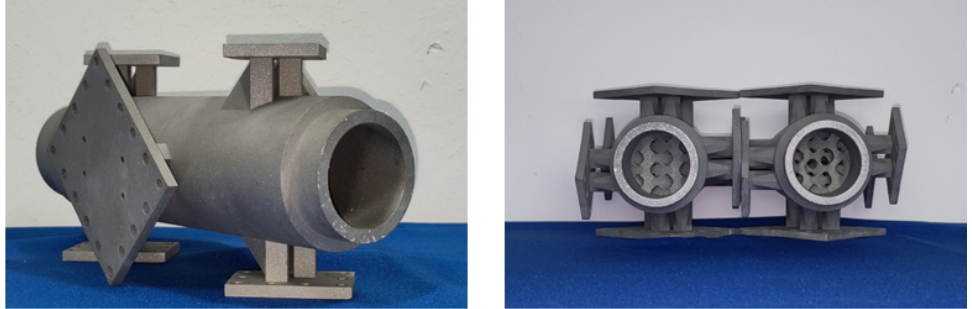
Figure 6. ( Left ) Manufactured static mixer with connectors for oil channels. ( Right ) Reference ( left ) and optimised ( right ) mixer geometries for validation